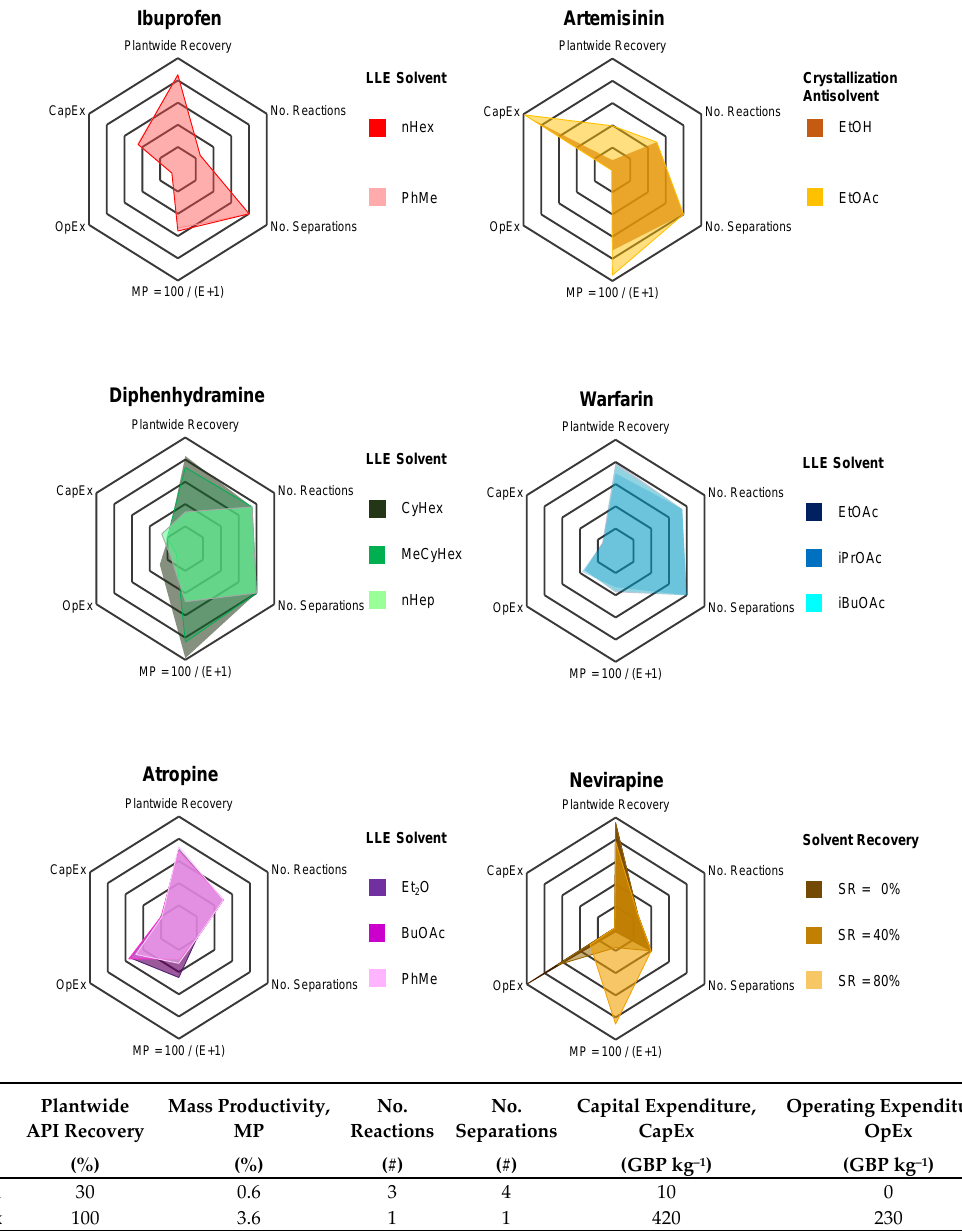
Figure 17. Performance metrics of various CPM processes for different APIs.